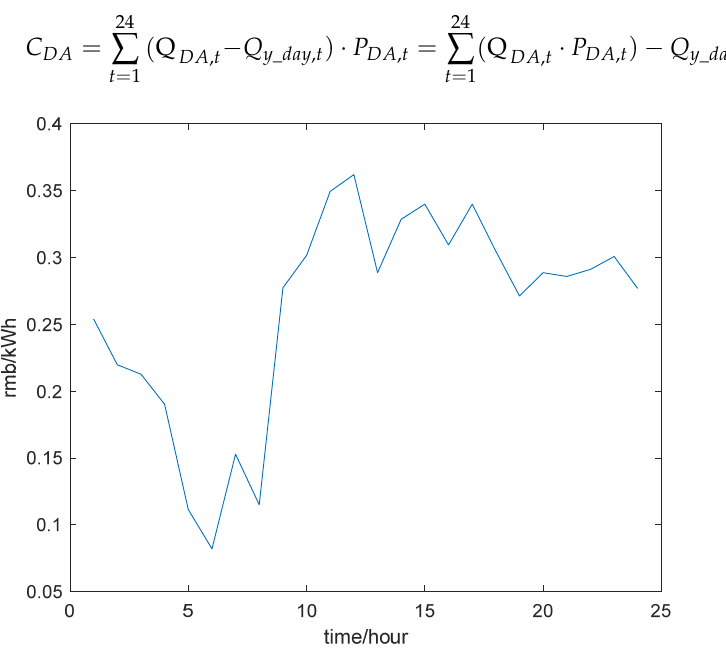
Figure 8. Forecast electricity price in the DA market.